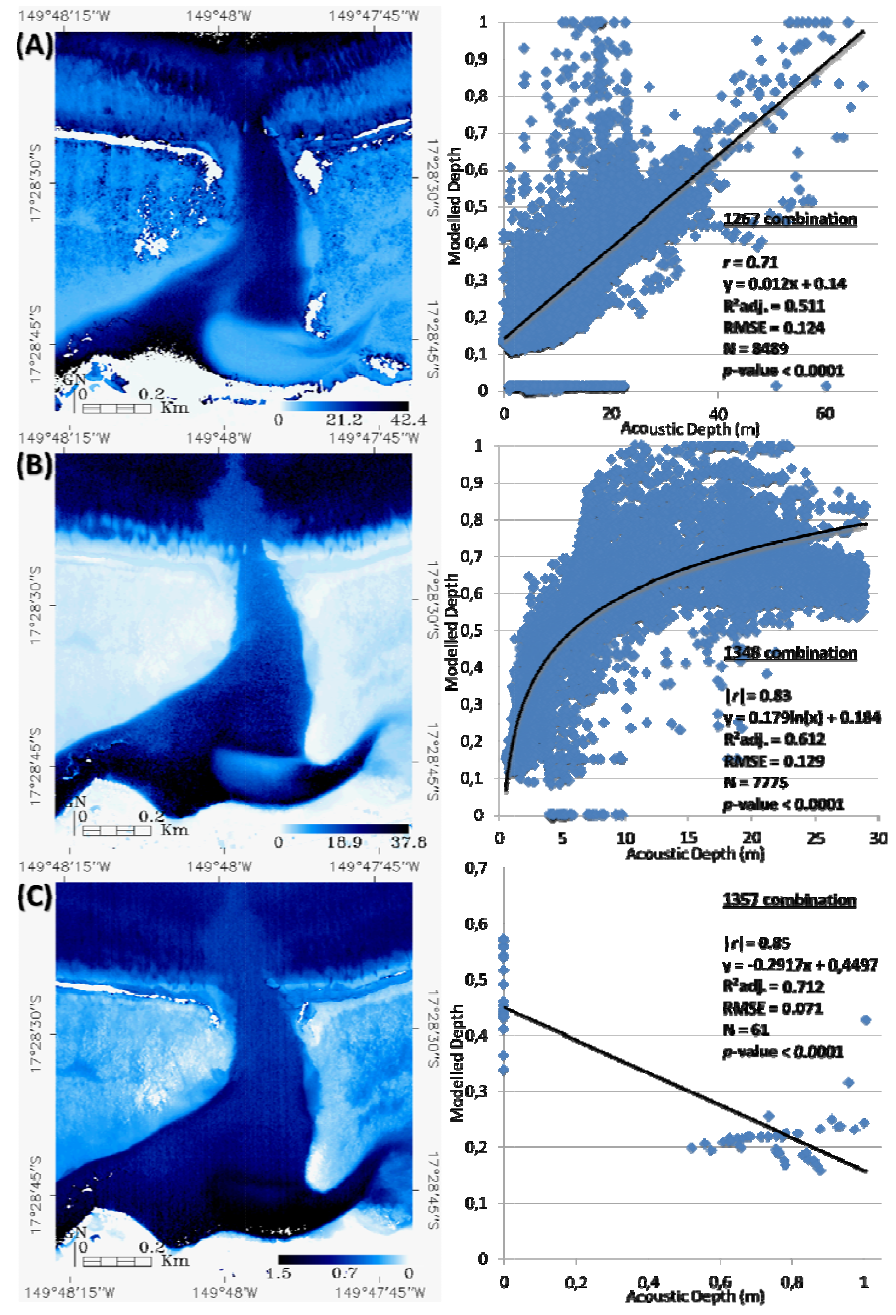
Figure acoust dark o